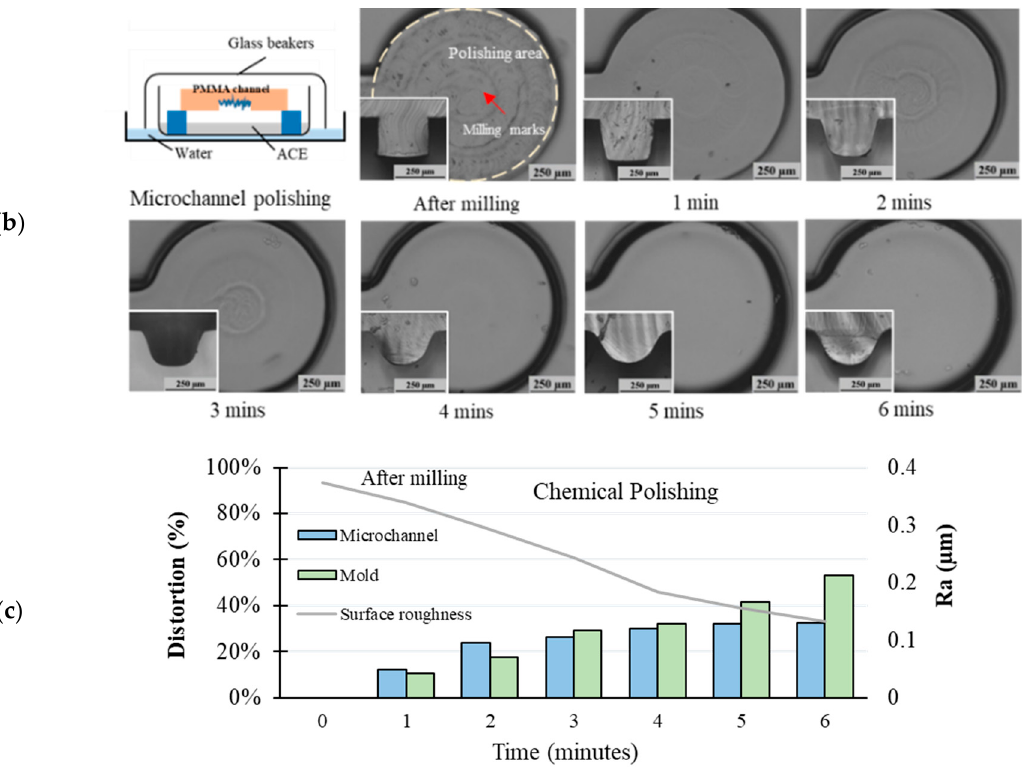
Figure 4. Top and cross-sectional (left-bottom) microscope images showing ( a ) micromolds and ( b ) microchannels immediately after milling (0 min) and after 6 min of chemical polishing. ( c ) Summary of distortion percentage and surface roughness (Ra).